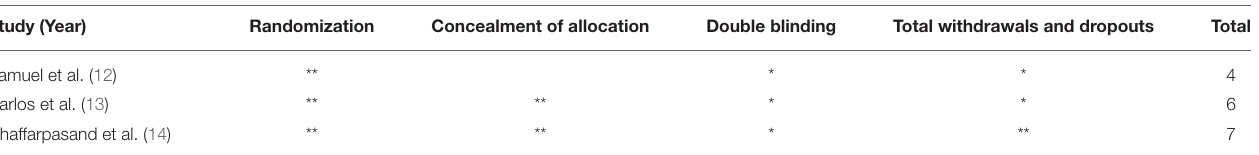
TABLE 3 | Modified Jadad Score for clinical